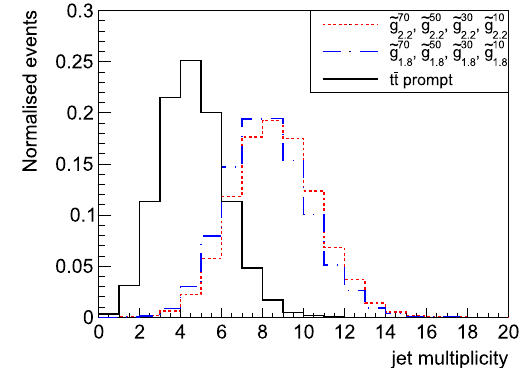
Fig. 79 Jet multiplicity N j in the gluino ˜ g case